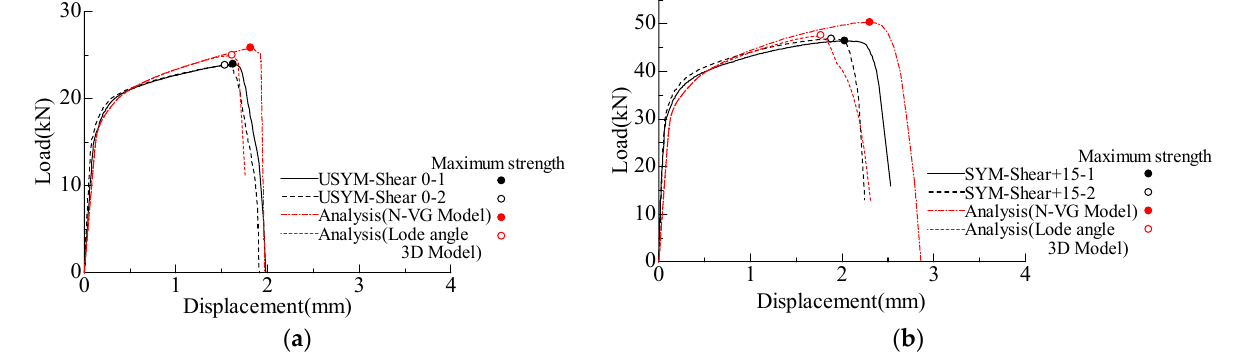
Figure 14. Comparison between test coupons and numerical result using N-VG model and 3D model: ( a ) USYM-Shear0 specimens; ( b ) SYM-Shear+15° specimens.